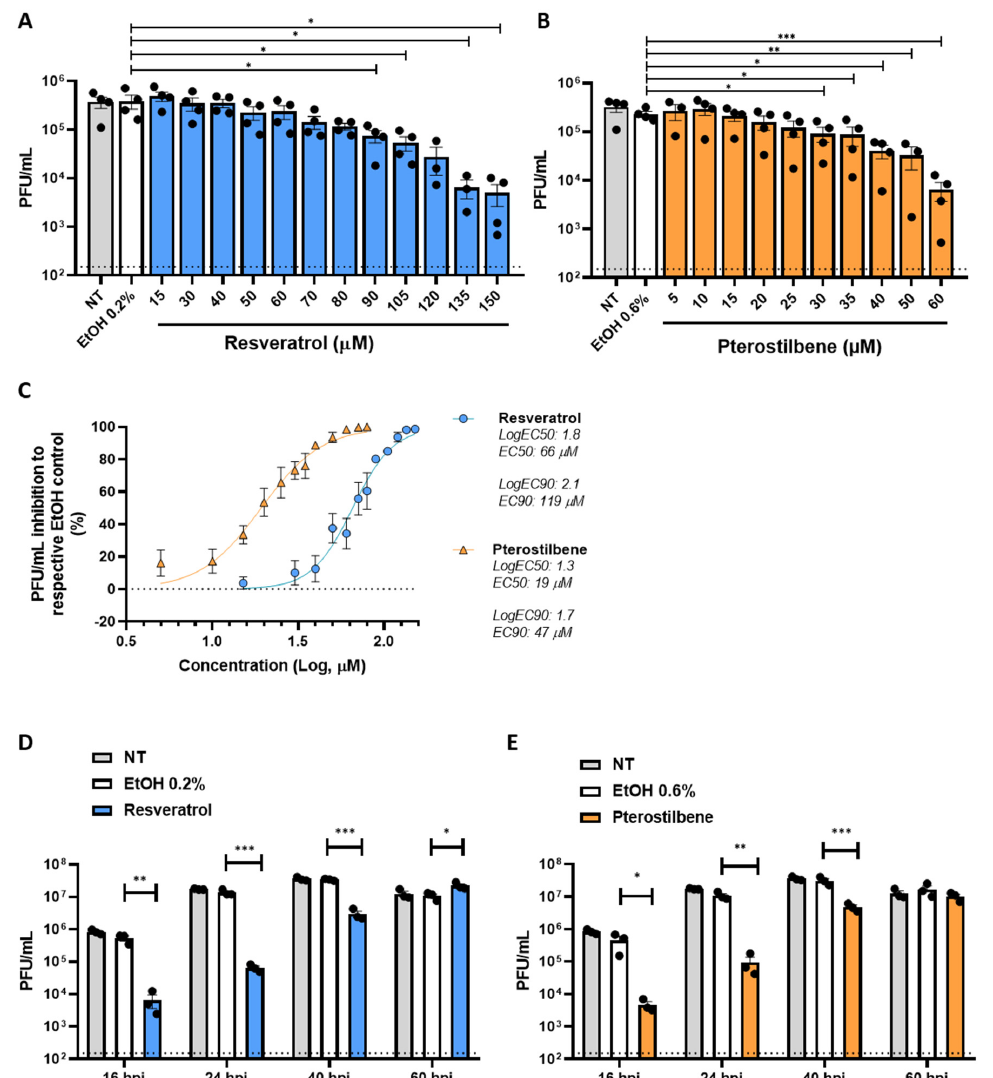
Figure 1. Antiviral effect of resveratrol and pterostilbene towards SARS-CoV-2 in Vero E6 cells. Production of infectious virus particles by Vero E6 cells inoculated with SARS-CoV-2 at MOI 1 in the absence (NT denotes for non-treated) or presence of increasing concentrations of ( A ) resveratrol, ( B ) pterostilbene or (A,B) the EtOH solvent control. ( C ) The EC50 and EC90 values determined by nonlinear regression analysis. ( D , E ) Durability of the antiviral effect of (D) resveratrol 150 µM and (E) pterostilbene 60 µM at 16, 24, 40, and 60 hpi. Dotted line indicates the threshold of detection. Data are represented as mean ± SEM of at least three independent experiments. Each symbol represents data from a single independent experiment. Student T test was used to evaluate statistical differences and a p value ≤ 0.05 was considered significant with * p ≤ 0.05, ** p ≤ 0.01 and *** p ≤ 0.001. In the absence of ‘*’ the data are non-significant.